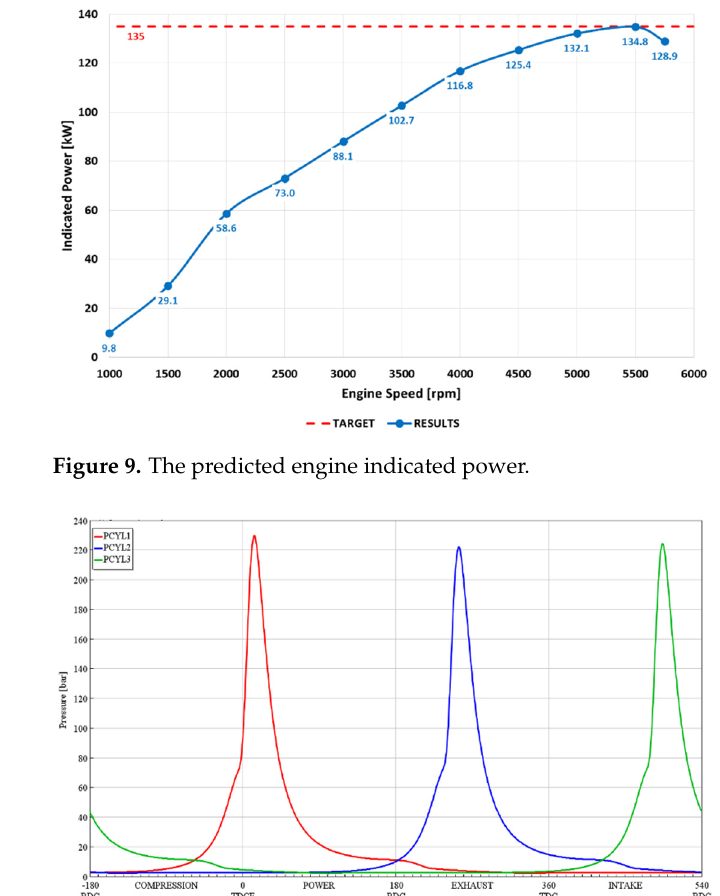
Figure 8. The predicted engine indicated torque.